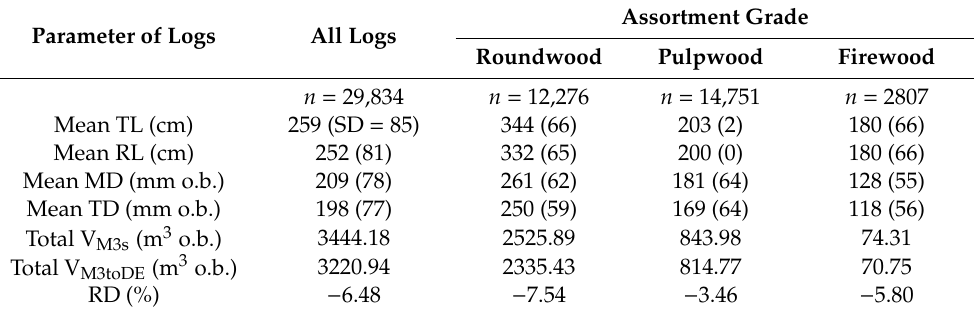
Table 3. Measured Scots pine timber parameters and estimated over-bark volumes of logs according to the M3s and M3toDE price